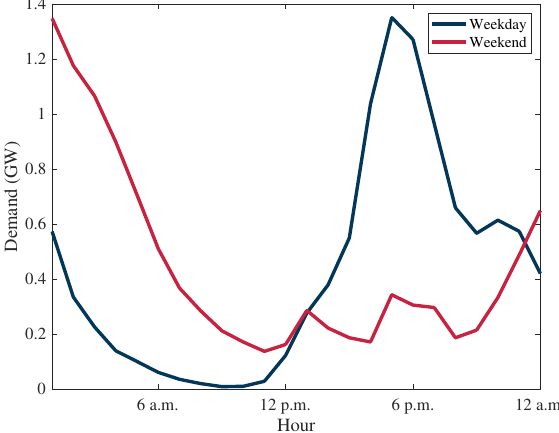
Figure 8. Electricity demand in GW for 1 million